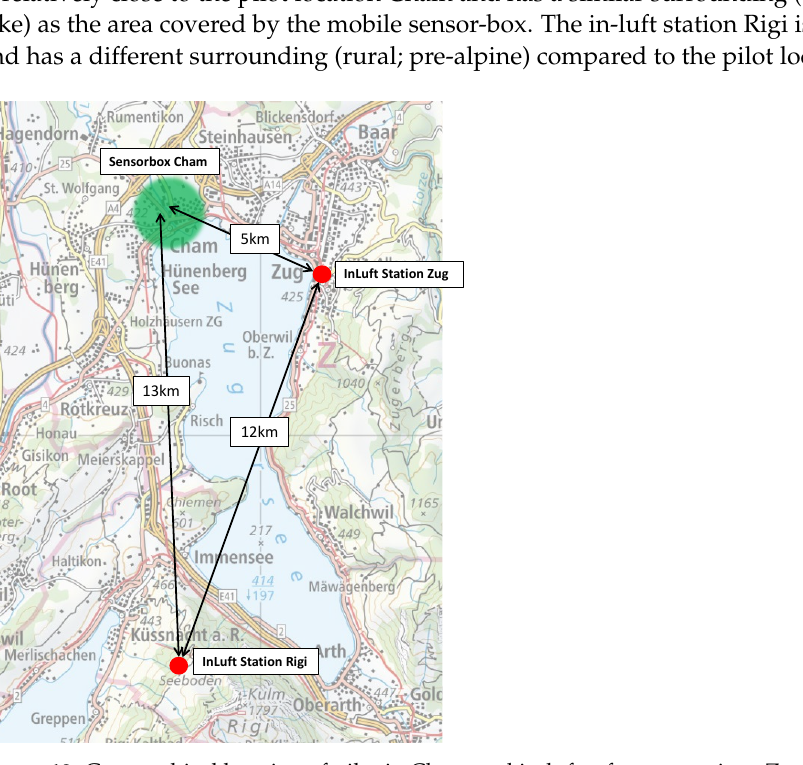
Figure 19. Geographical location of pilot in Cham and in-luft reference stations Zug and Rigi. (Map source: Federal Office of Topography). Table 10. Location profile of in-luft reference stations